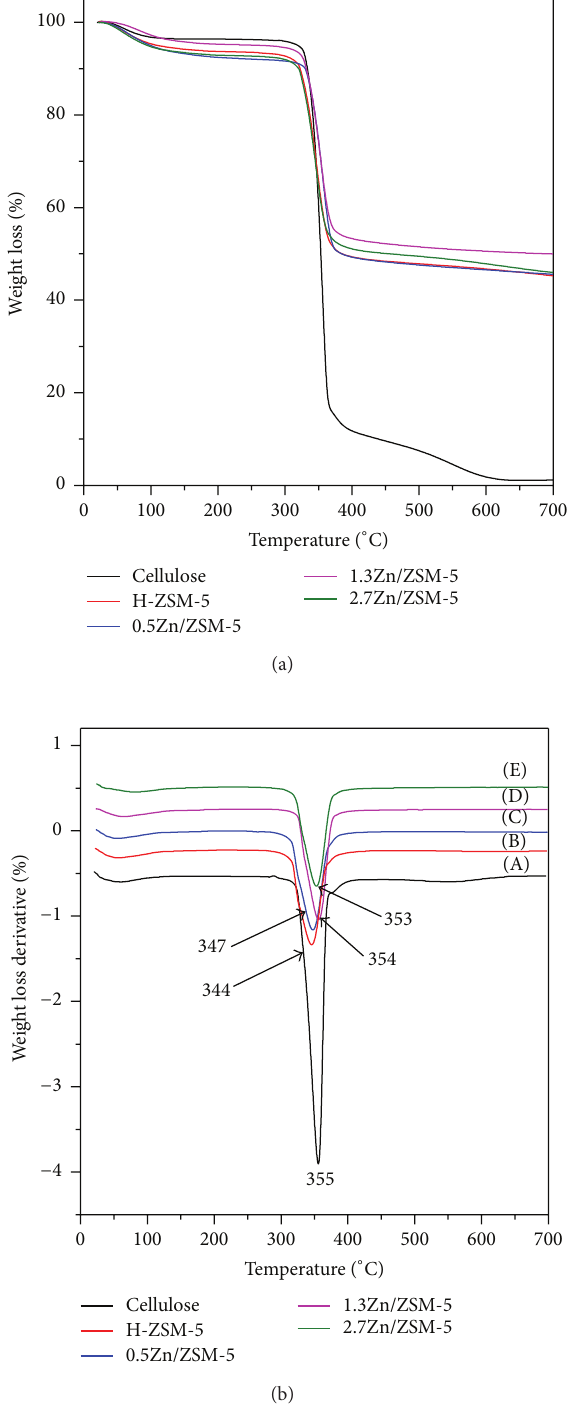
Figure 5: (a) TG and (b) DTG curves of (A) the noncatalytic pyrolysis of cellulose, (B) the catalytic pyrolysis of cellulose with H- ZSM-5, (C) the catalytic pyrolysis of cellulose with 0.5 Zn/ZSM-5, (D) the catalytic pyrolysis of cellulose with 1.3 Zn/ZSM-5, and (E) thecatalyticpyrolysisofcellulosewith2.7Zn/ZSM-5.Themassratio of the catalyst to cellulose is equal to